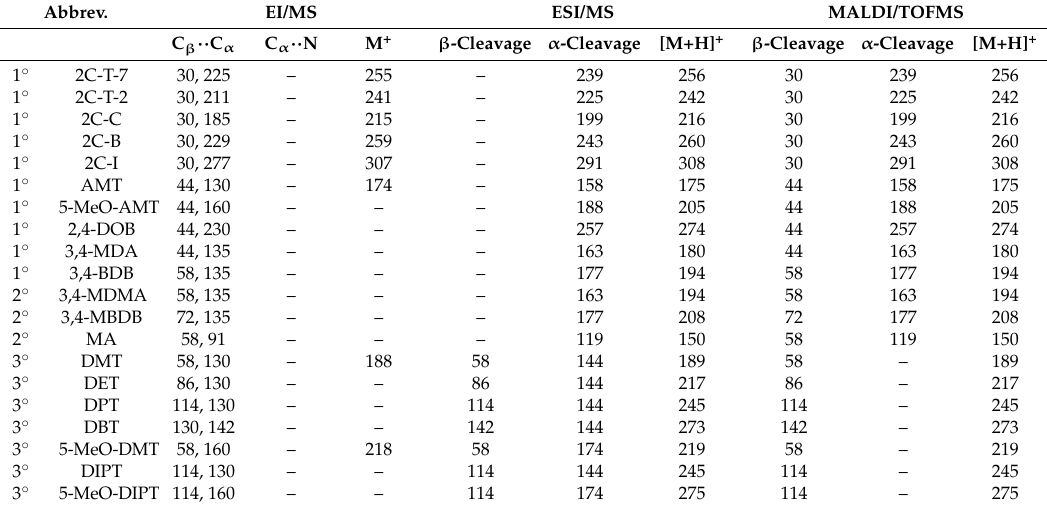
Table 2. Mass fragmentations ( m / z values) of phenethylamines and tryptamines based on EI/MS, ESI/MS and MALDI/TOFMS, respectively. The three types of amines show different characteristic mass fragments. The symbols of 1 ◦ , 2 ◦ and 3 ◦ are abbreviations of primary, secondary and tertiary amines,